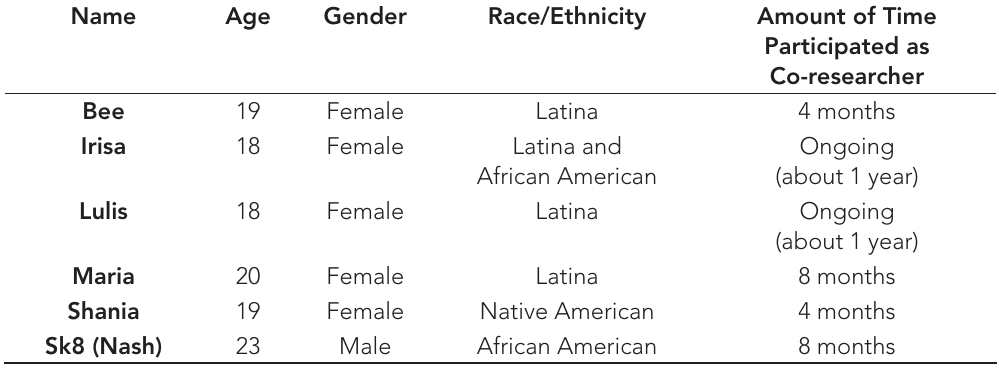
Table 4: Demographic characteristics of co-researchers (alternative high school)